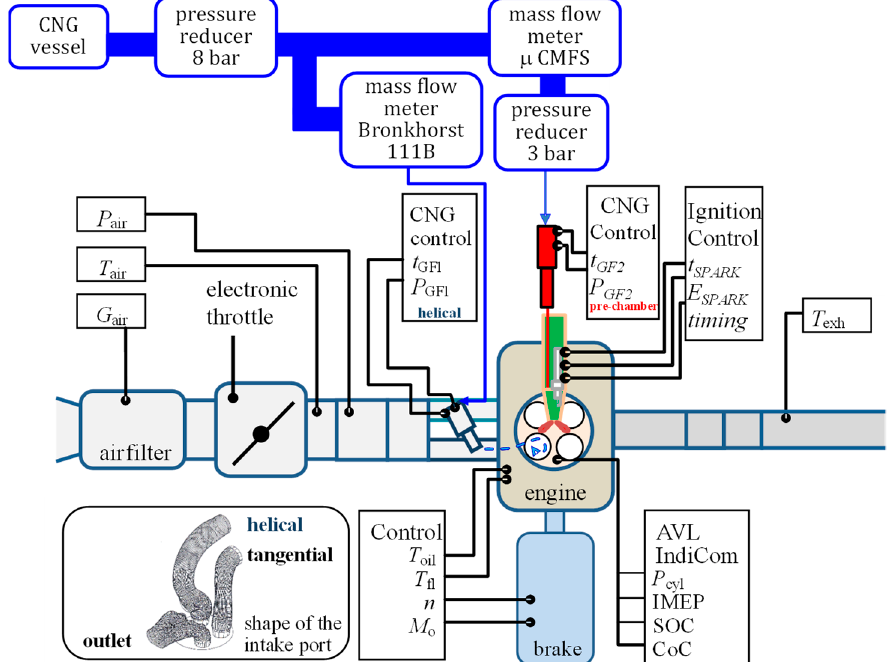
Figure 3. Schematic of the measurement system analysis for the two-stage combustion system with the AVL 5804 engine and the apparatus for engine indication and exhaust emission analysis.